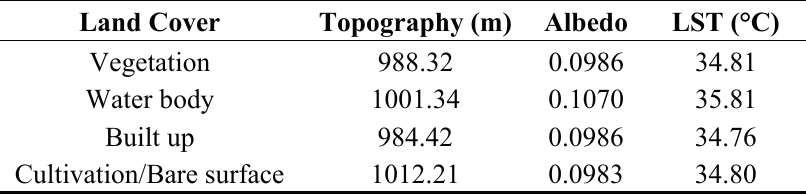
Table 10. Mean topography, mean albedo and mean LST across land cover types in Jos in